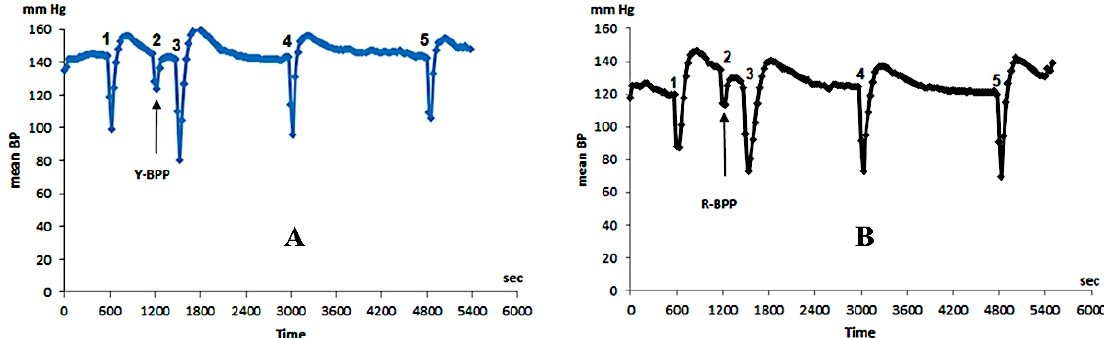
Figure 8. Bradykinin-potentiating effects of A. feae peptides Y-BPP and R-BPP. Changes in mean blood pressure (BPs) (absolute values) after administration of bradykinin at a dose of 7 µg/kg (injections at points 1, 3, 4, 5) and Y-BPP ( A ) or R-BPP ( B ) at a dose of 300 µg/kg (injection at point 2).